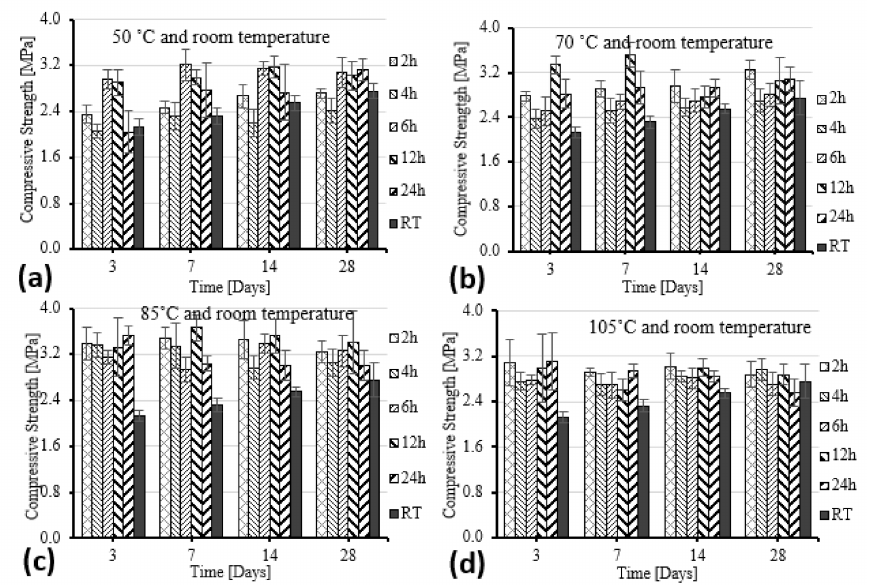
Figure 3. Compressive strength of GF at different curing temperatures: ( a ) 50 ◦ C, ( b ) 70 ◦ C, ( c ) 85 ◦ C and ( d ) 105 ◦ C.